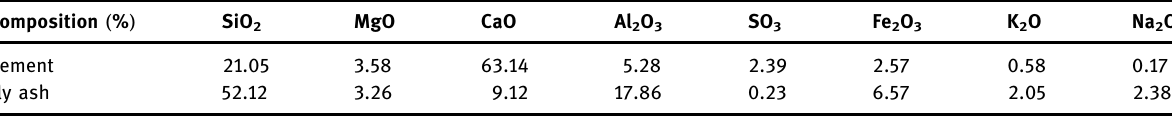
Table 1: Composition of cement and fl y ash Composition ( % ) Cement